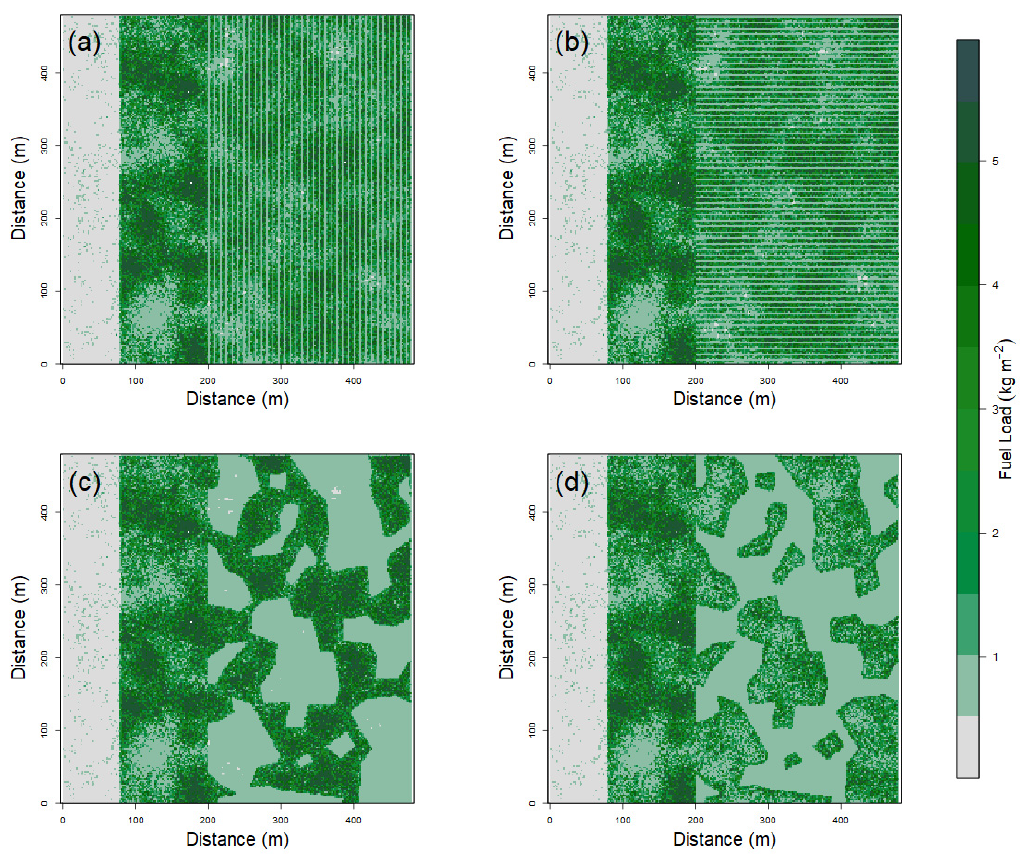
Figure 1. Mulch fuel treatment configuration for ( a ) perpendicular strips, ( b ) parallel strips, ( c ) cluster treatment: thin removed, and ( d ) cluster treatment: dense removed. Control scenario not shown. Each treatment scenario removes 50% of the treed areas.